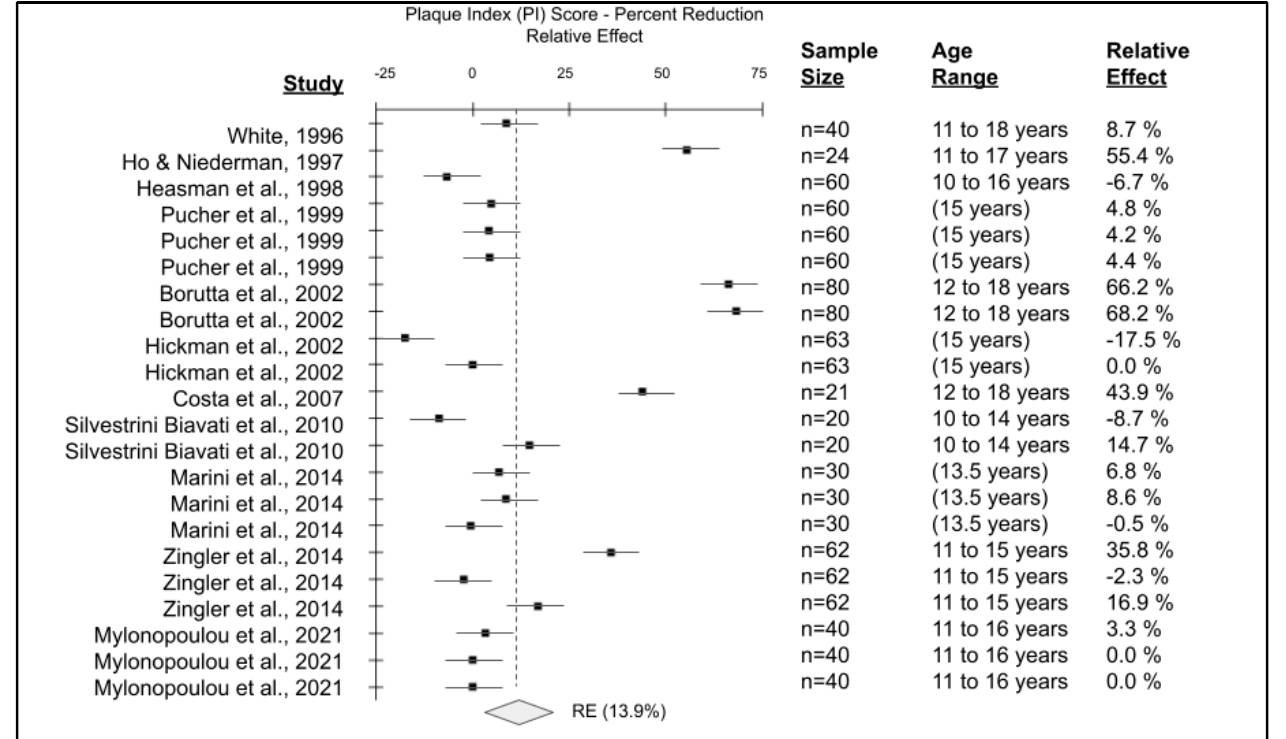
Figure 7. Forest plot of pediatric, orthodontic studies of manual versus electric toothbrushing comparing plaque index (PI). A total of n = 11 studies were evaluated with sample sizes ranging from n = 20 to n = 80 were plotted to determine an average reduction in plaque index or relative effect (RE)